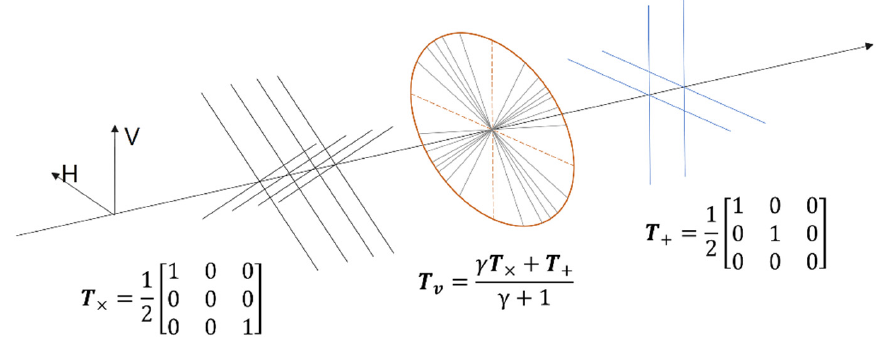
Figure 1. Dipole aggregation model with adaptive parameter γ .